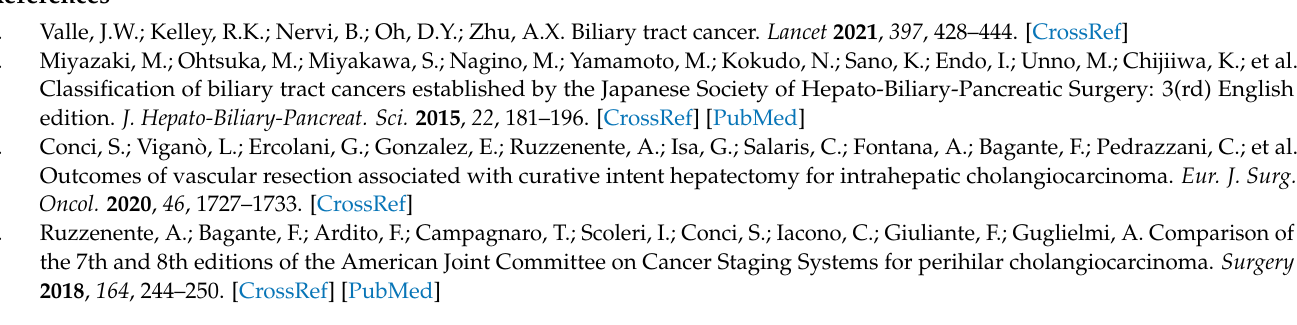
factors, Table S1: Comparison of Clinical and pathological characteristics according to the type of BTC, Table S2: Comparison of distribution of Inflammatory-based and nutritional prognostic scores according to the type of BTC, Table S3: Mortality according to the different inflammatory and immune-nutritional